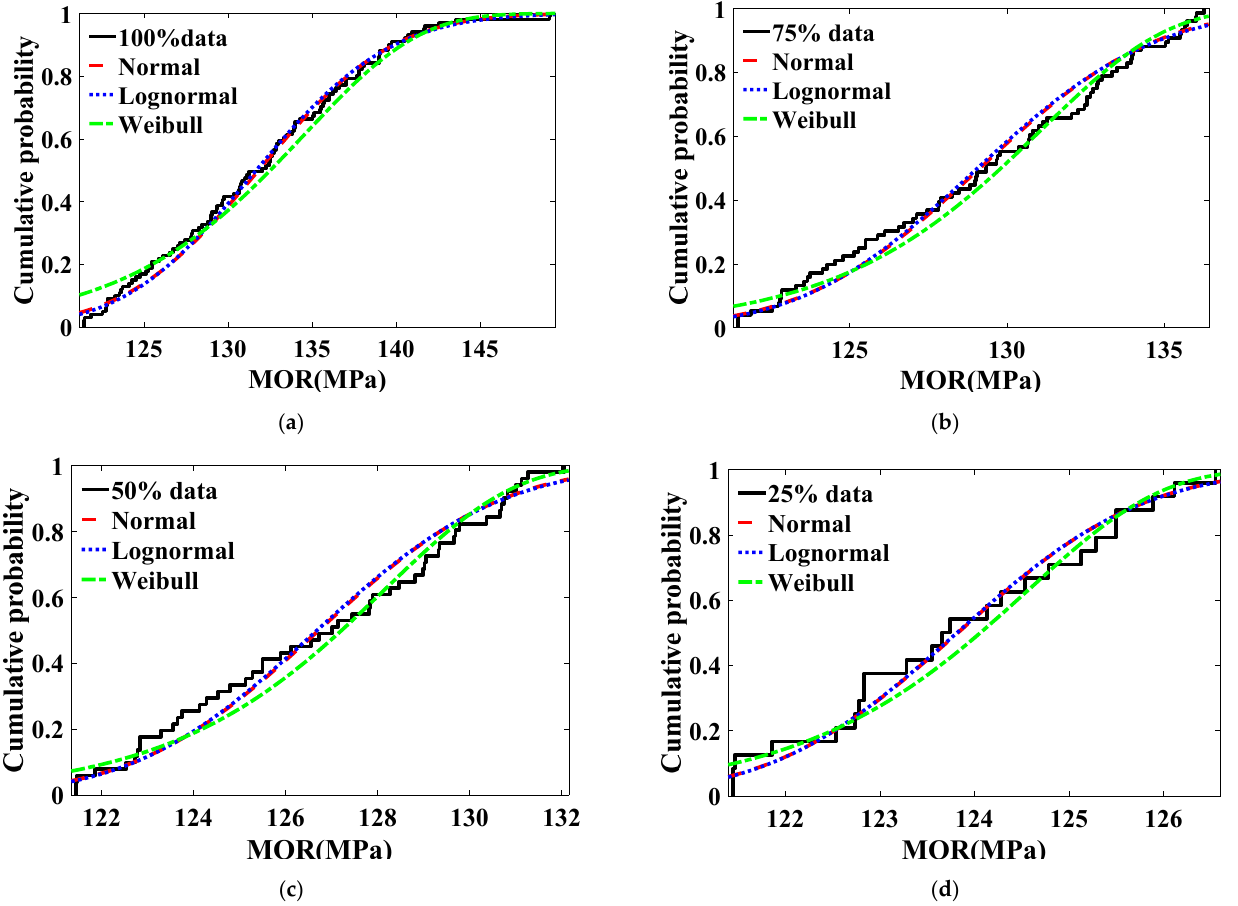
Figure 4. Cumulative probability fitting results of bamboo bending strength under different probability distributions (grade Ⅱ ): ( a ) n = 100%N; ( b ) n = 75%N; ( c ) n = 50%N; ( d ) n = 25%N.